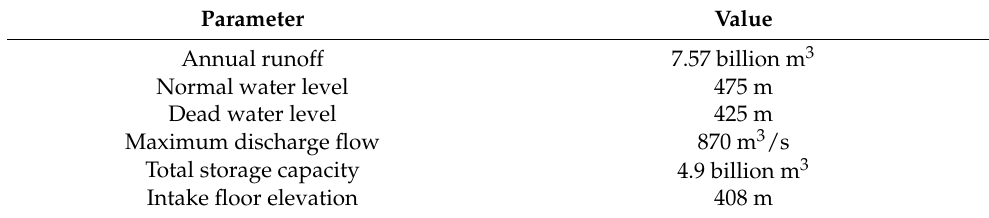
Table 1. Basic parameters of the deep water reservoir.